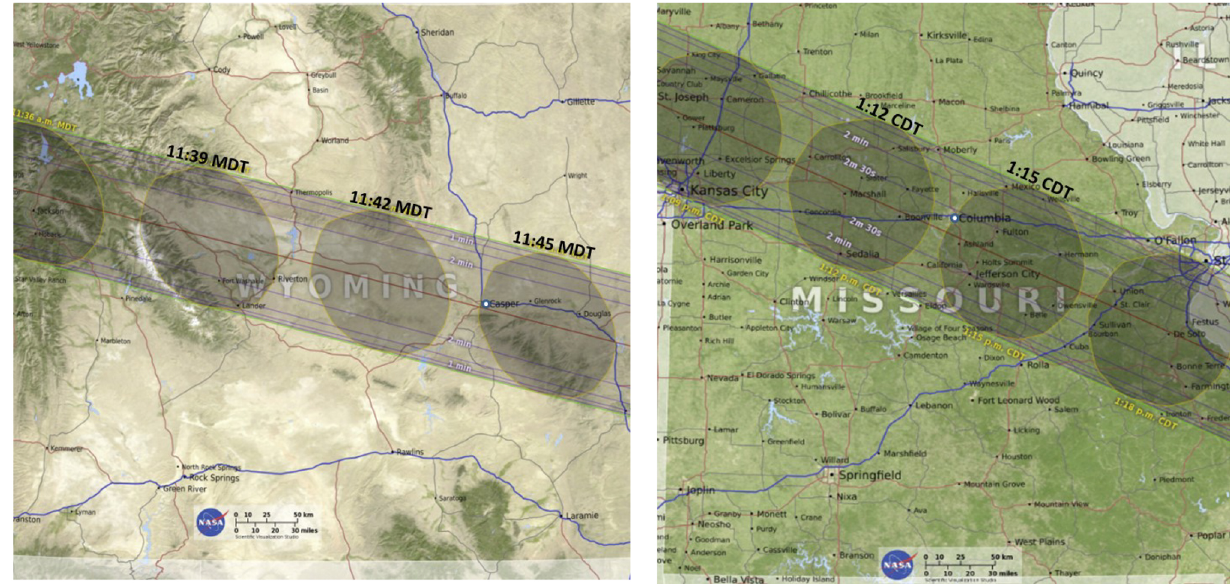
Figure A1. The timing and shape of the Moon’s shadow over Casper, Wyoming, showing the relative location of Casper and Columbia (white circles) at 11:45MDT (Mountain Daylight Time) and 13:15CDT (Central Daylight Time). The shadow is moving at about 46kmmin − 1 (https://eclipse2017.nasa.gov/eclipse-maps). The scale size with the NASA logo is